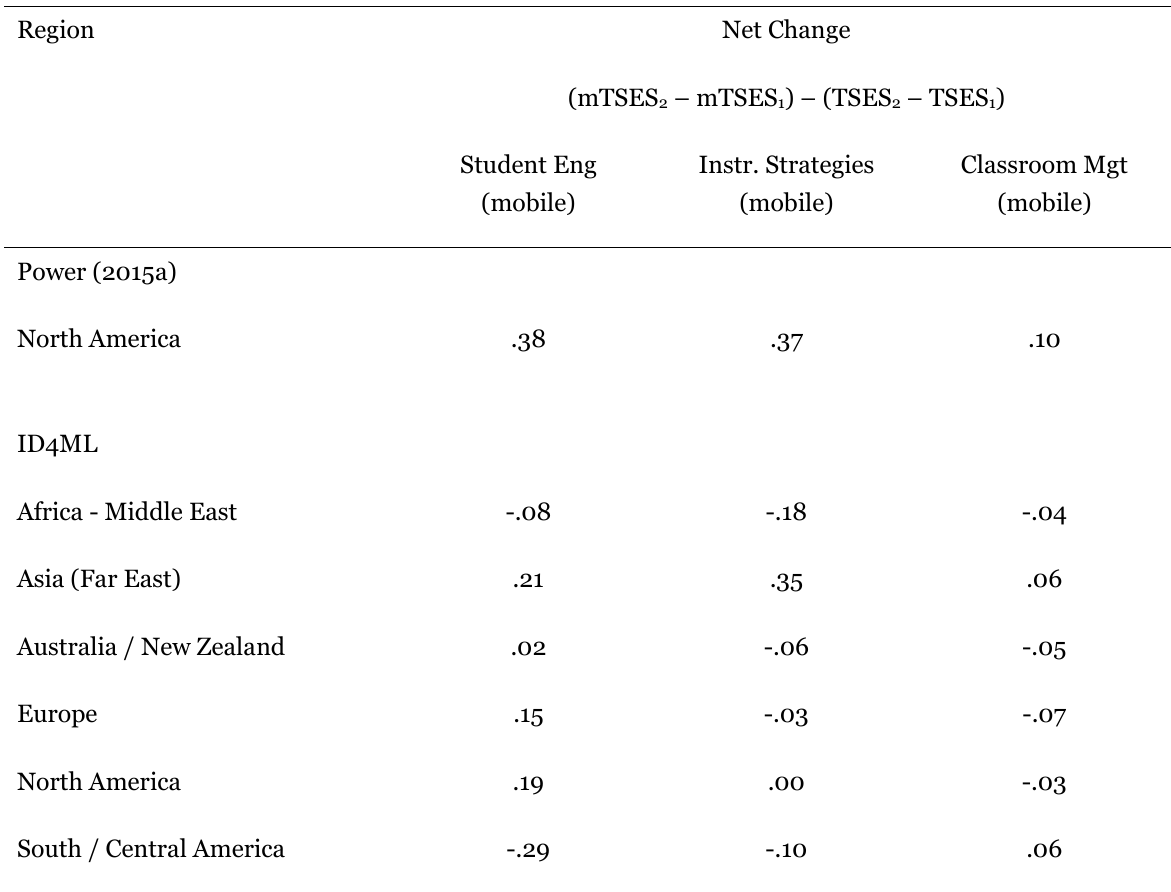
Table 11 Net Change (Intervention Effect) According to